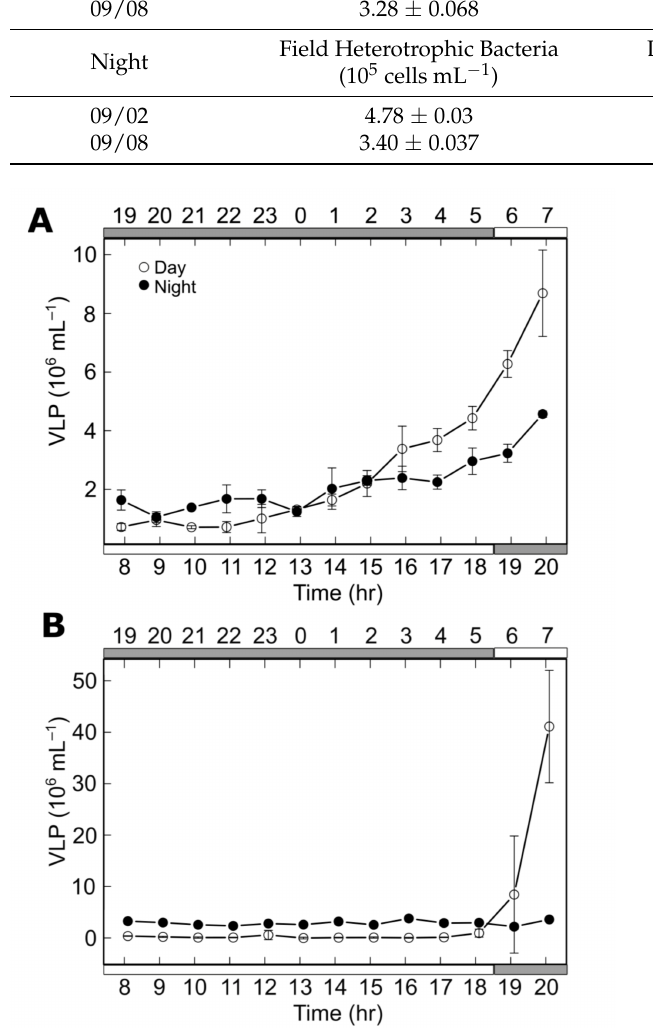
Figure 1. Temporal variation in density of virus-like particles (VLP). Daytime incubations from 8:00–20:00 (open circles and lower axis) and nighttime incubations from 19:00–7:00 the next morning (filled circles and higher axis). Experiments were conducted on 2 September 2020 ( A ) and on 8 September 2020 ( B ). Periods without sunlight are shaded. The standard deviation of VLP is labeled as a vertical line at each time